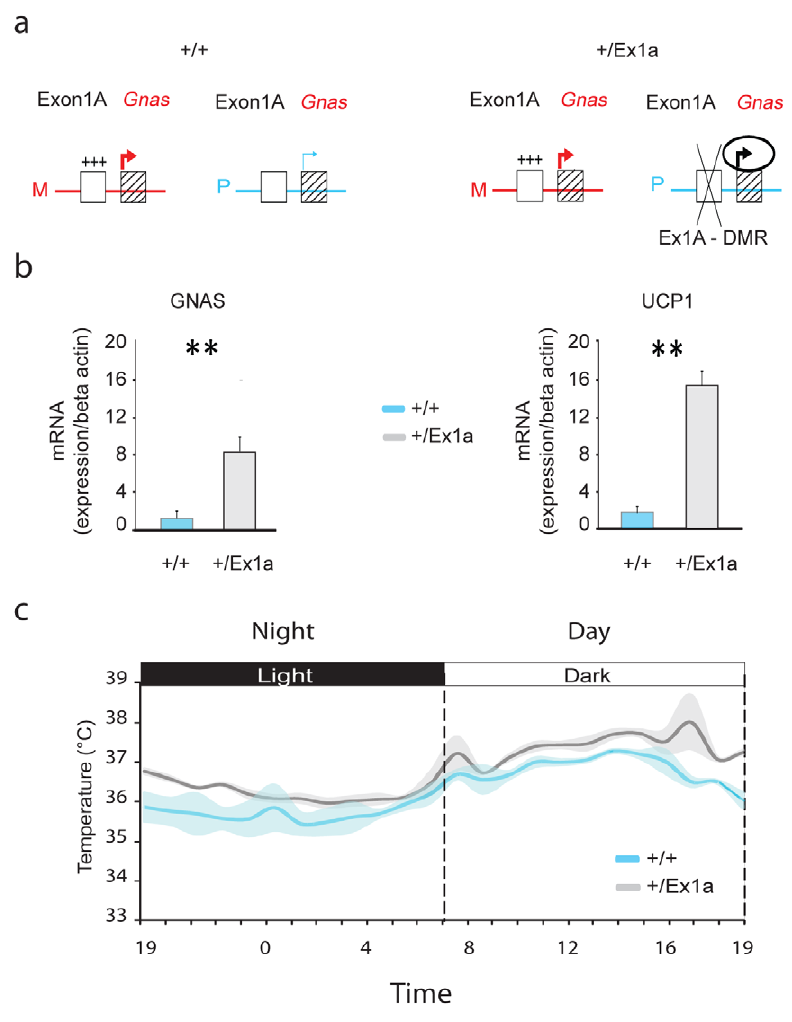
Figure 1. Exon 1A deletion: Gnas expression and body temperature. (a) Representation of Gnas expression when the Exon1A-DMR (Ex1A- DMR) is methylated on the maternal (M) allele in + / + and + / Ex1a or deleted on the paternal (P) allele in + / Ex1a mice. (b) Expression levels, by q-PCR measurements, in BAT tissue of Gnas (left panel) and Ucp1 (right panel) mRNA in + / + versus mutant + /Ex1a mice. (c) Grand-averages and shadowed 6 s.e.m. of body temperature over a 24-hour period for + / + and + / Ex1a mice. Statistics are reported as following: t -test; **= P , 0.01.